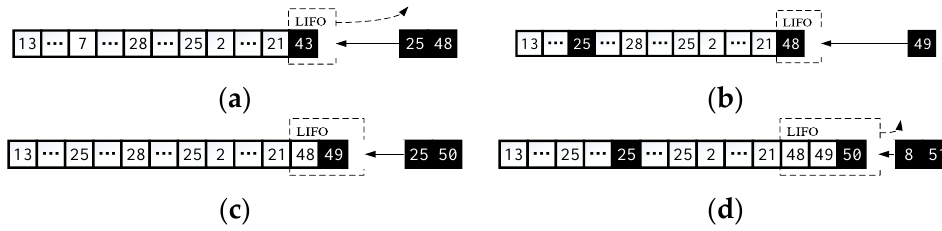
Figure 6. Array structure updating processes in the priority queue from 48th to 50th sequentially in SNIC. ( a ) Popping 43rd from Q before pushing 25th and 48th; ( b ) pushing 49th on Q ; ( c ) pushing 25th and 49th on Q ; ( d ) popping 48th to 50th from Q before pushing 8th and 51th. The sequence of elements is corresponding to the minimum heap in Figure 5. Solid elements indicate that they are newly inspected and pushed in the current and next step. A last-in-first-out (LIFO) stack with dotted arrows means that the elements are popped in the batch. Notice that there is more than one 25th in each array that is inspected by different pixels.